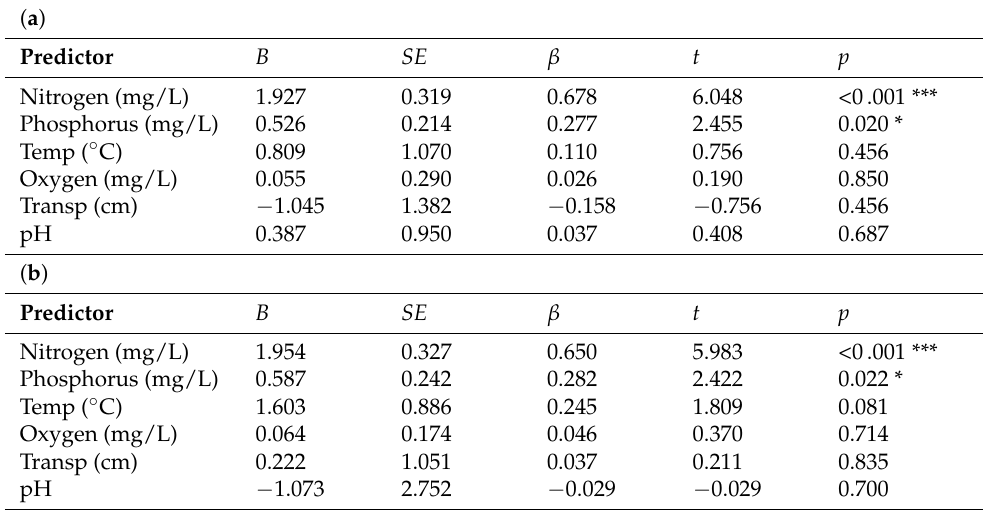
Table 1. The multiple linear regression results showing the influence of physico-chemicals variables on algal biomass at lakes; (a) Big Momella and (b) Rishateni, Tanzania during the study period